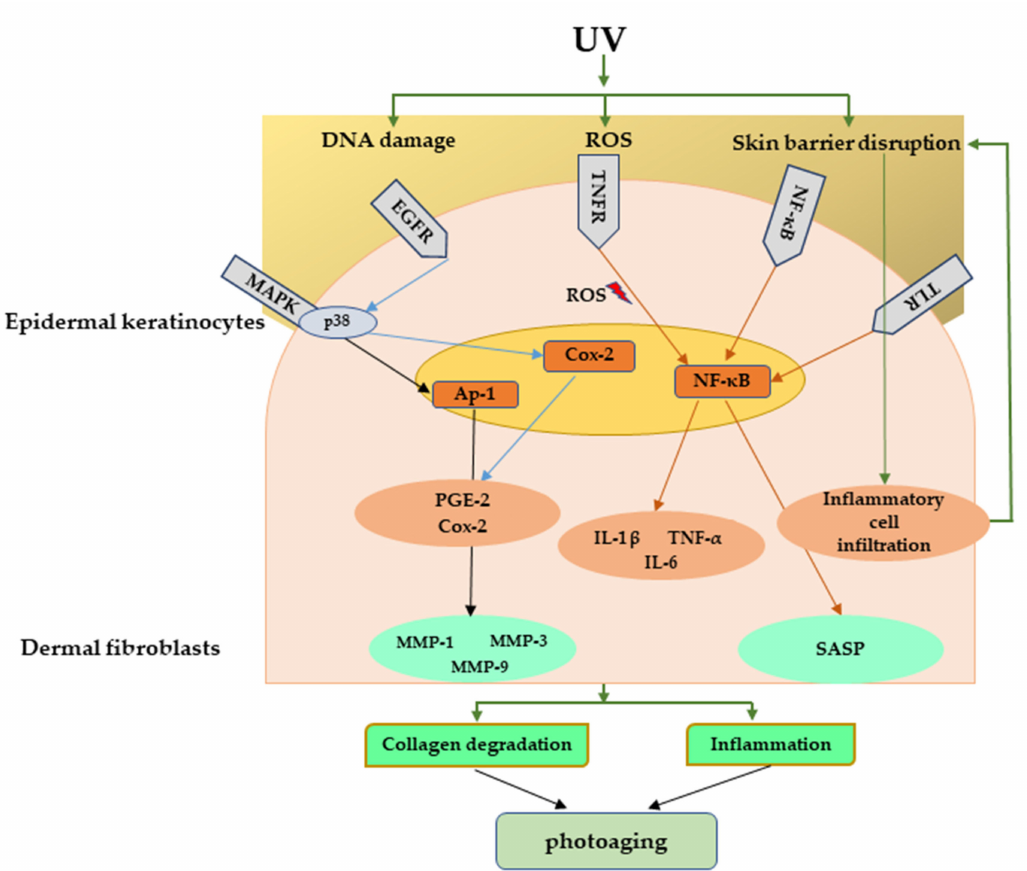
Figure 5. Major signaling pathways involved in UV-mediated photoaging. UV radiation can cause direct damage to the DNA, produce ROS, and disrupt skin barrier function. These can further activate many inflammatory receptors, which can lead to photoaging through inflammation and collagen degradation. UV, Ultraviolet; ROS, reactive oxygen